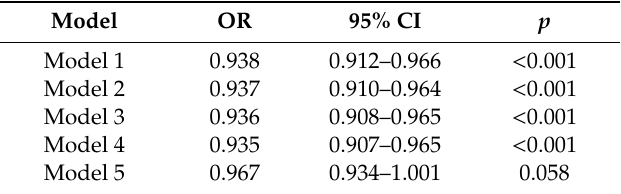
Table 2. Odds ratio (OR) and 95% confidence interval (CI) of serum chemerin with liver cirrhosis. Model 1: adjusted for age and BMI; Model 2: adjusted for age, BMI, and gender; Model 3: adjusted for age, BMI, gender, and viral load; Model 4: adjusted for age, BMI, gender, viral load, alanine aminotransferase, and aspartate aminotransferase; Model 5: adjusted for age, BMI, gender, viral load, alanine aminotransferase, aspartate aminotransferase, and the MELD score.